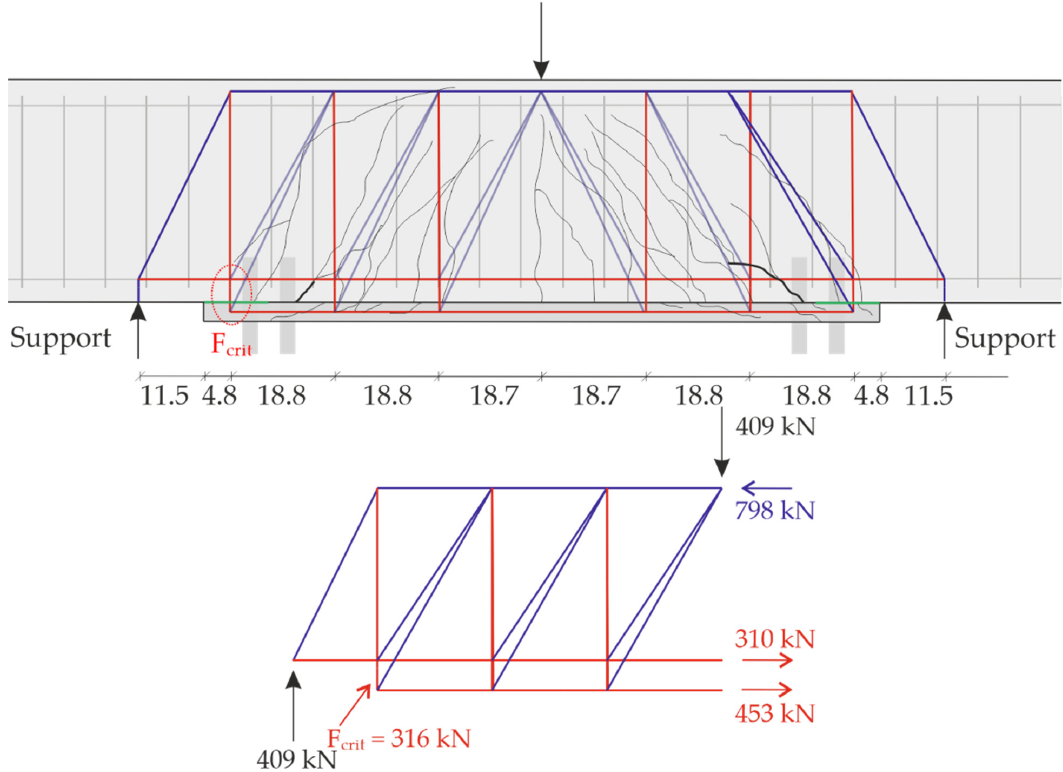
Figure 27. Adapted strut-and-tie-model. (Graphic: CARBOCON GMBH).